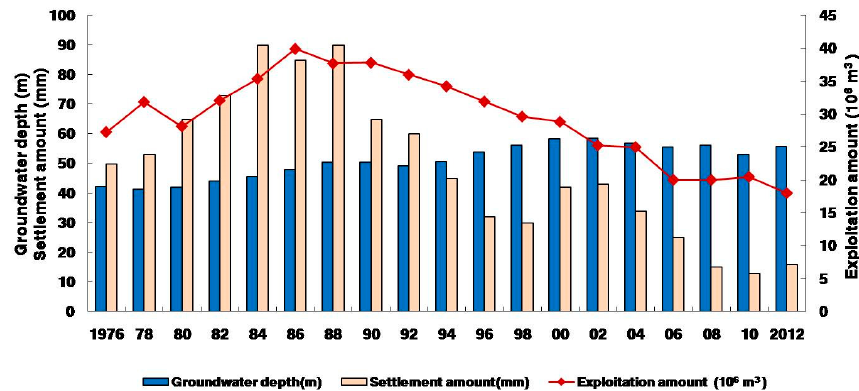
Figure 8. Relationship among groundwater exploitation amount, groundwater depth and settlement amount of land subsidence in the Su-Xi-Chang region.